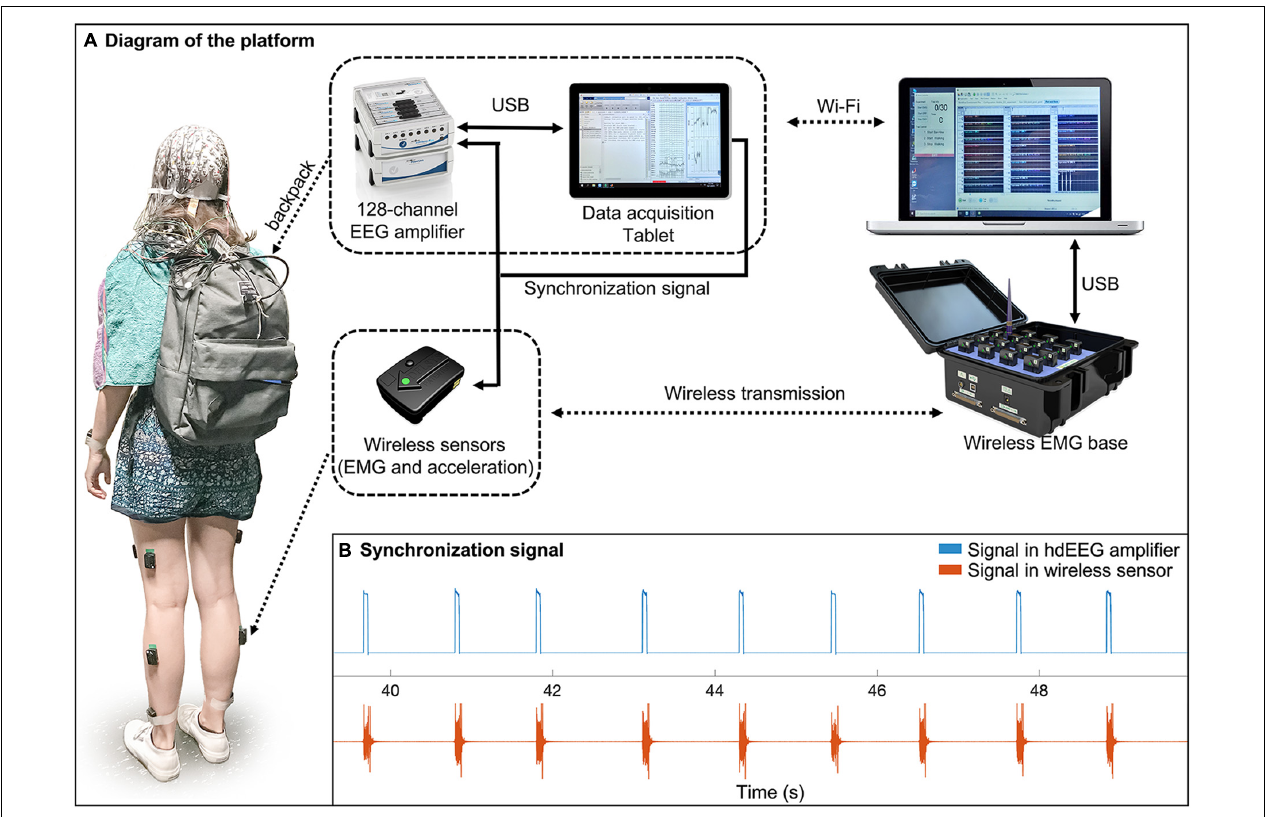
FIGURE 1 | Diagram of the mobile brain-body imaging platform. (A) The platform consists of three parts: a backpack, a set of wireless body sensors, and a base station. The backpack contains a high-density EEG (hdEEG) amplifier, an EEG data acquisition tablet, and a light-weighted battery for powering the amplifier. During the experiment, a participant wears a hdEEG cap that is connected to the EEG amplifier in the backpack. The amplifier is connected to a tablet in the backpack for reliable EEG data recording. The EEG recording software on the tablet is remotely controlled by a laptop via Wi-Fi connection. The laptop is also connected to a wireless sensor base that receives EMG and acceleration data from sensors attached on the participant. The EEG system and wireless sensor system are synchronized by receiving a synchronization signal from the tablet through an auxiliary channel and one of the wireless sensors, respectively. (B) An example of synchronization signals recorded from the two